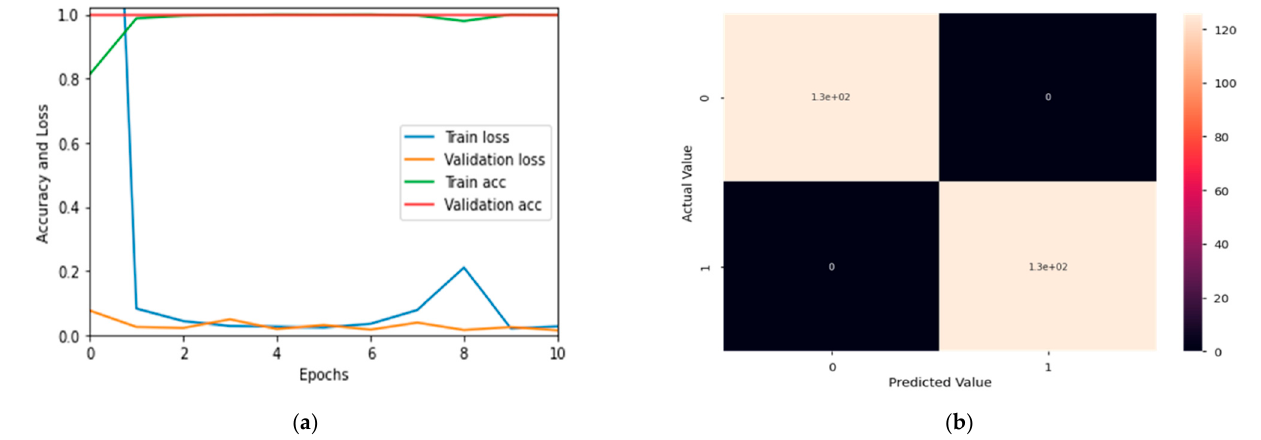
Figure 13. ( a ): A visual representation of accuracy and loss on training and validation on Imam-HR and ( b ) Confusion matrix of implemented CAD-HR on Imam-HR.